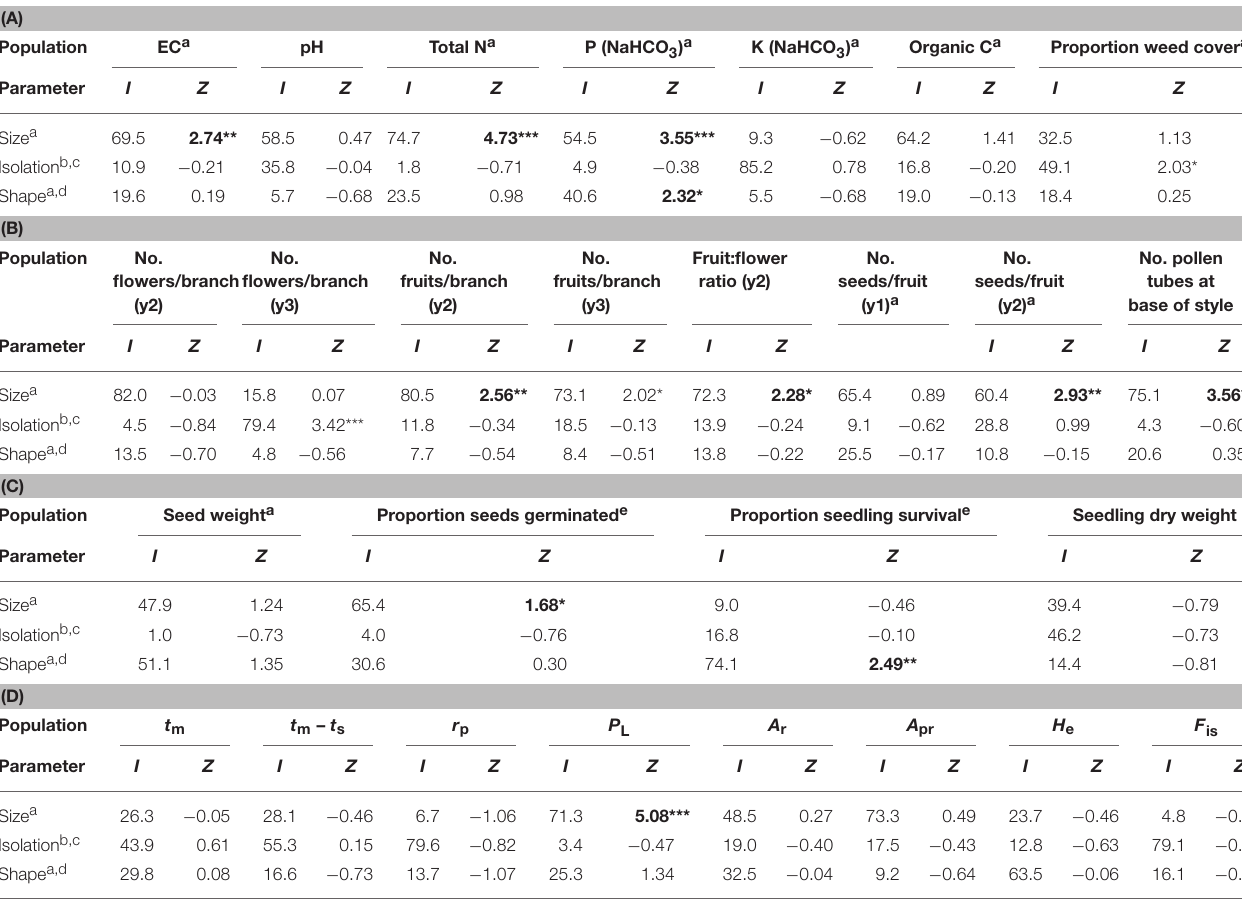
TABLE 3 | The percentage independent contribution (I) of population size, isolation and shape to variation in measures of (A) soil chemical properties and weed cover, (B) reproduction, (C) progeny performance and (D) the mating system and genetic diversity for 19 populations of Eucalyptus wandoo , determined by hierarchical partitioning.